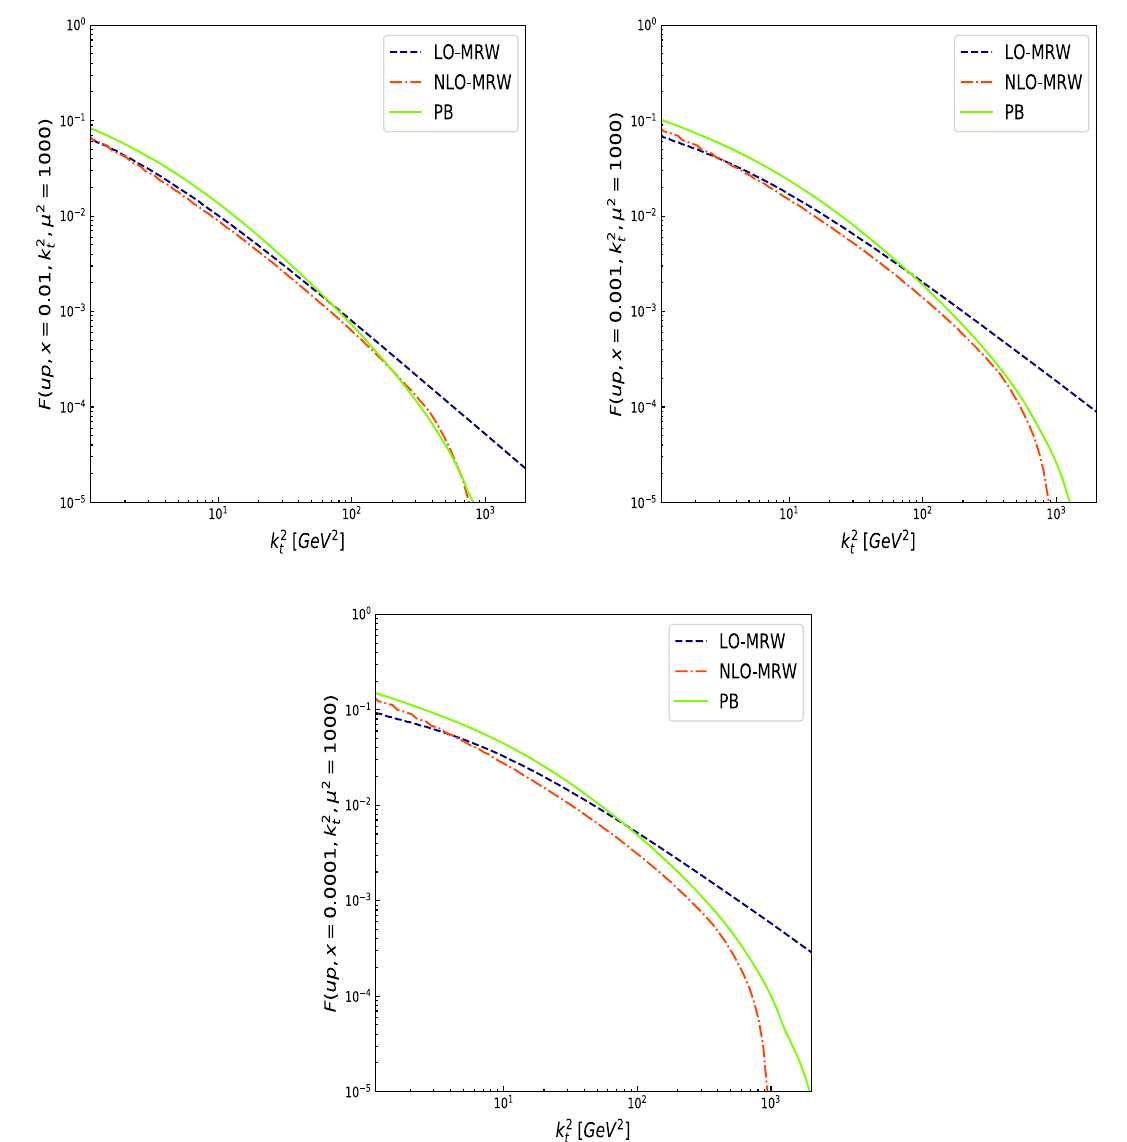
Fig. 3 The same as Fig. 2 but for up quark